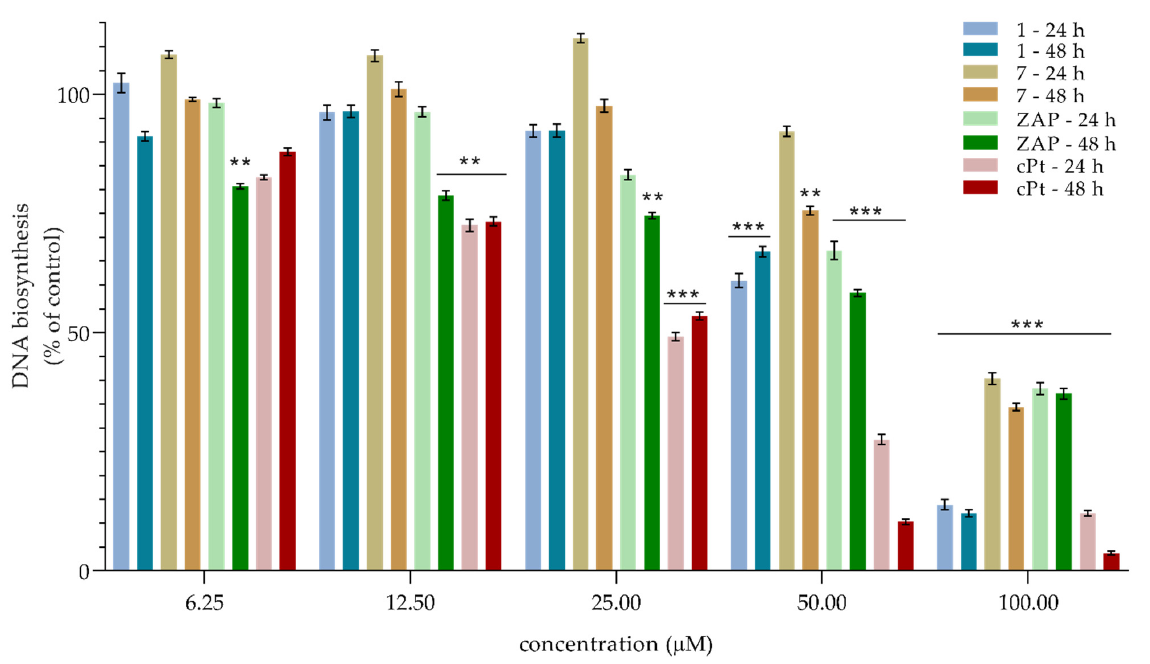
Figure 7. The decreasing effects of 1 , 7 , zapotin ( ZAP ) , and cPT ( µ M) on DNA biosynthesis in SCC-25 cells for 24 h and 48 h of incubation. Mean percentages from at least three independent experiments conducted in duplicate are presented. ** p < 0.01 versus control group, *** p < 0.001 versus control group.